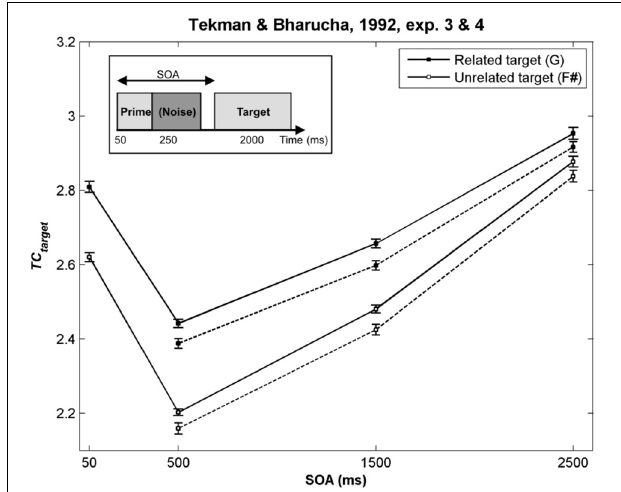
FIGURE 3 | TC of the target chords used by Tekman and Bharucha (1992) as a function of the SOA. In this study, a silence (Experiment 3, solid lines) and a noise (Experiment 4, dash lines) were inserted between the two chords. The prime chord sounded for 50ms, and could be followed by a silence or a noise of variable duration. The target chord then sounded for 2000ms (see insert ). In all cases, the TC of the related target chord was higher than that of the unrelated target, thus predicting the facilitation effect observed behaviorally. Error bars represent standard errors between experimental